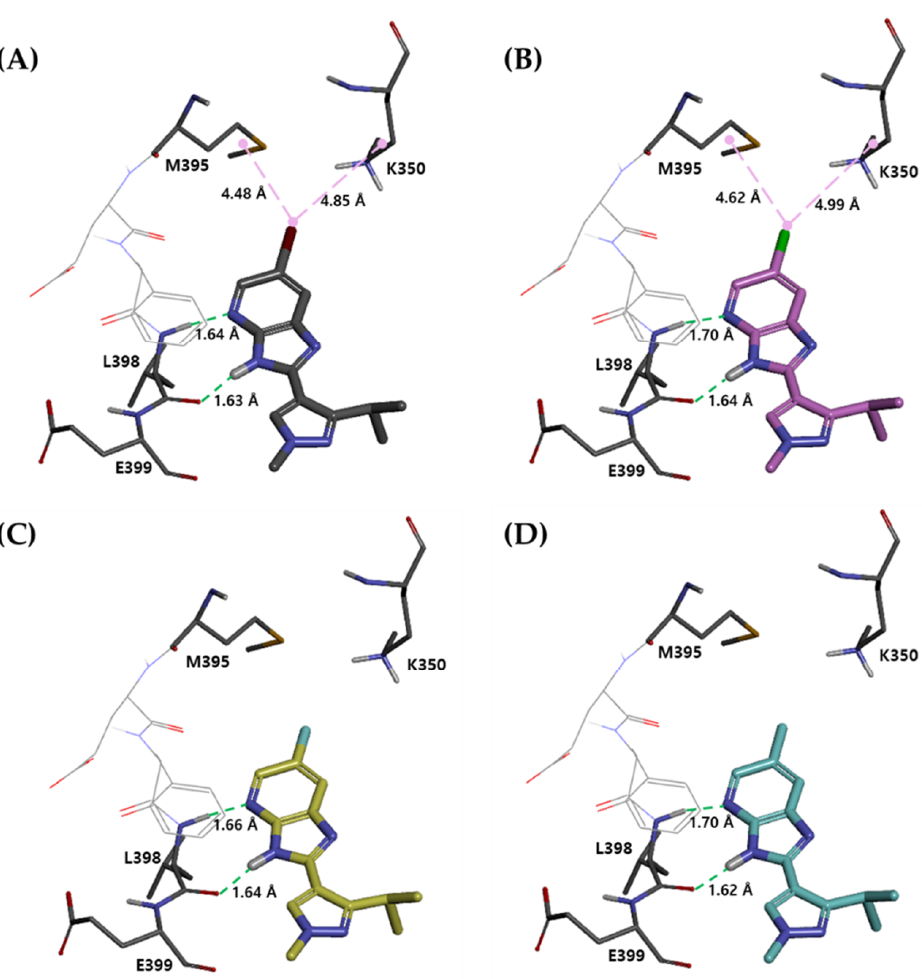
Figure 2. Binding modes of ( A ) compound 1 , ( B ) compound 2 , ( C ) compound 3 , and ( D ) compound 4 inside the PAK4 binding pocket. Ligands are shown as stick models, while hydrogen bonding interactions are displayed as green dashed lines, and van der Waals interactions are displayed as a pink line. Hydrogen bond distances are provided in Å.